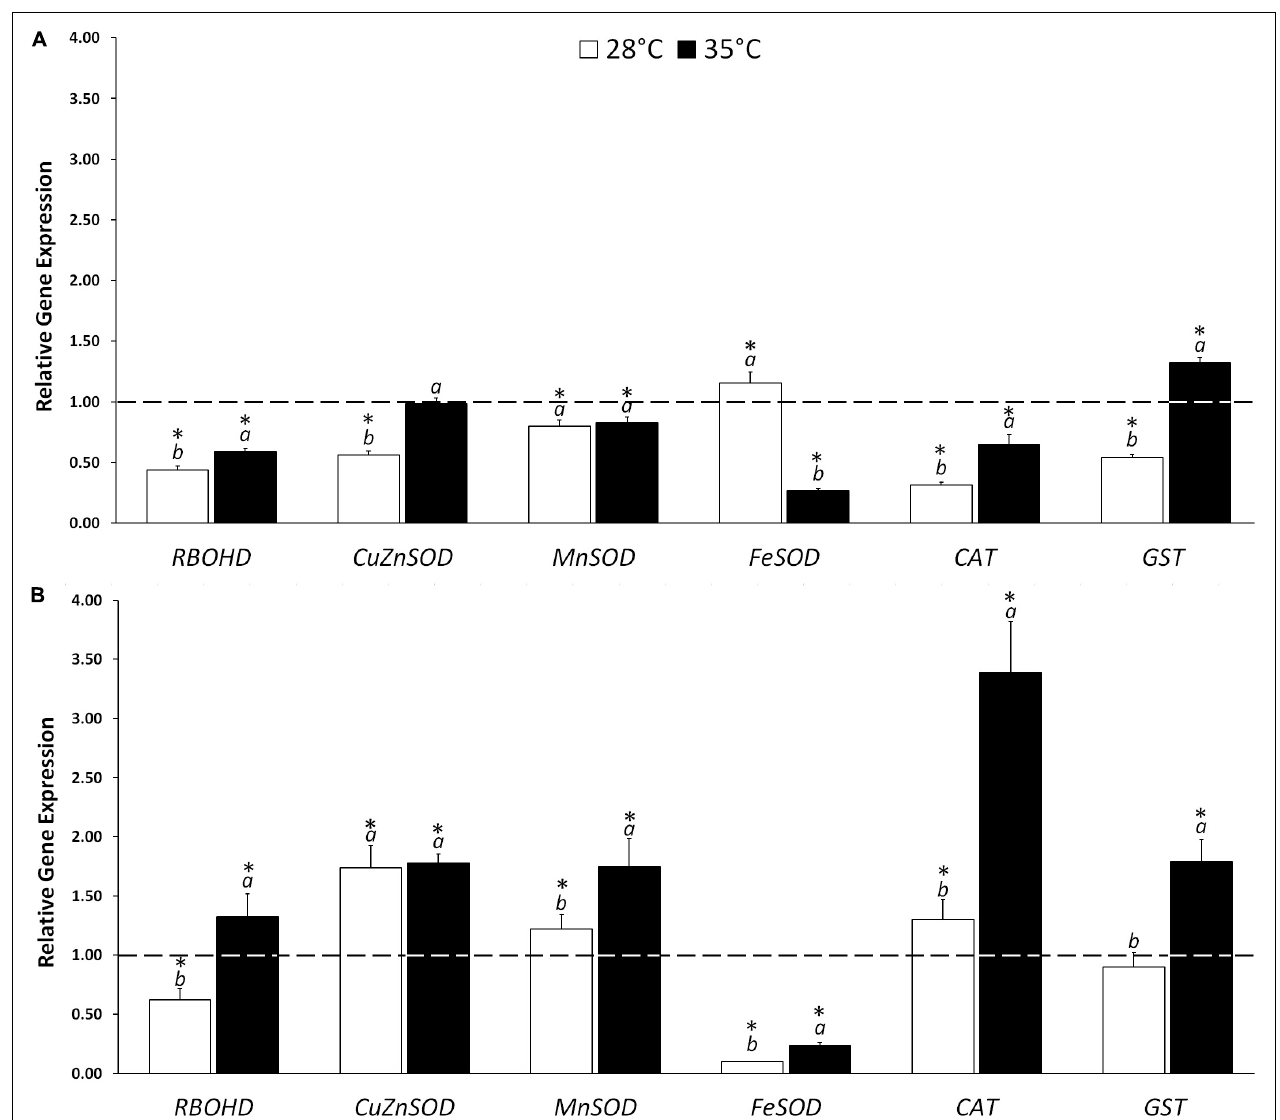
FIGURE 1 | Effect of KIEM R (cid:13) on expression levels of genes coding for ROS producing ( RBOHD ) and scavenging ( CuZnSOD , MnSOD , FeSOD , CAT, and GST ) enzymes after 24 (A) and 48 h (B) from seed incubation. Values are expressed as a relative gene expression obtained by comparing KIEM R (cid:13) -treated samples with the corresponding untreated controls (dotted line). Bars represent the mean ± SD of three biological replicates. For each bar, different lowercase letters indicate significant differences ( p ≤ 0.05) between treatments with the biostimulant at the two different temperatures (28 and 35 ◦ C), as measured by ANOVA followed by Tukey’s post hoc test. Asterisks (*) indicate significant differences ( p ≤ 0.05) between KIEM R (cid:13) -treated samples and the correspective untreated control at the same temperature condition, as measured by t -test.